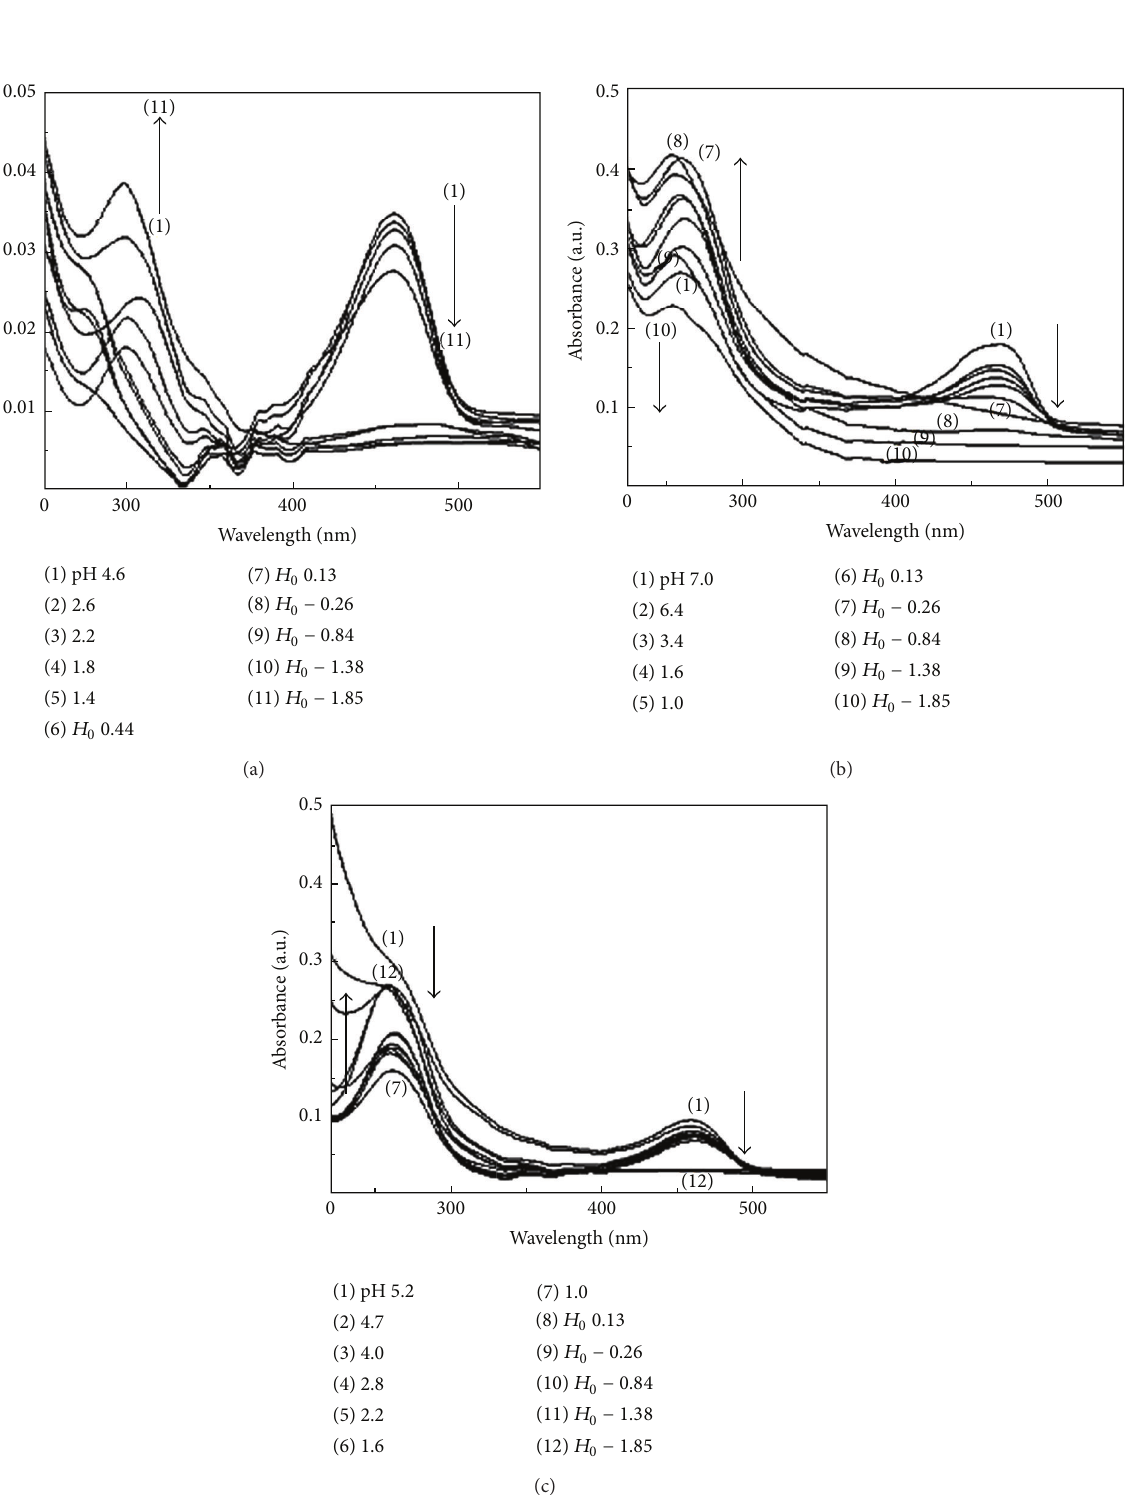
Figure 8: (a) Absorbance spectra of C334 at various pH in water. (b) Absorbance spectra of C334 at various pH in 𝛽 -CD. (c) Absorbance spectra of C334 at various pH in